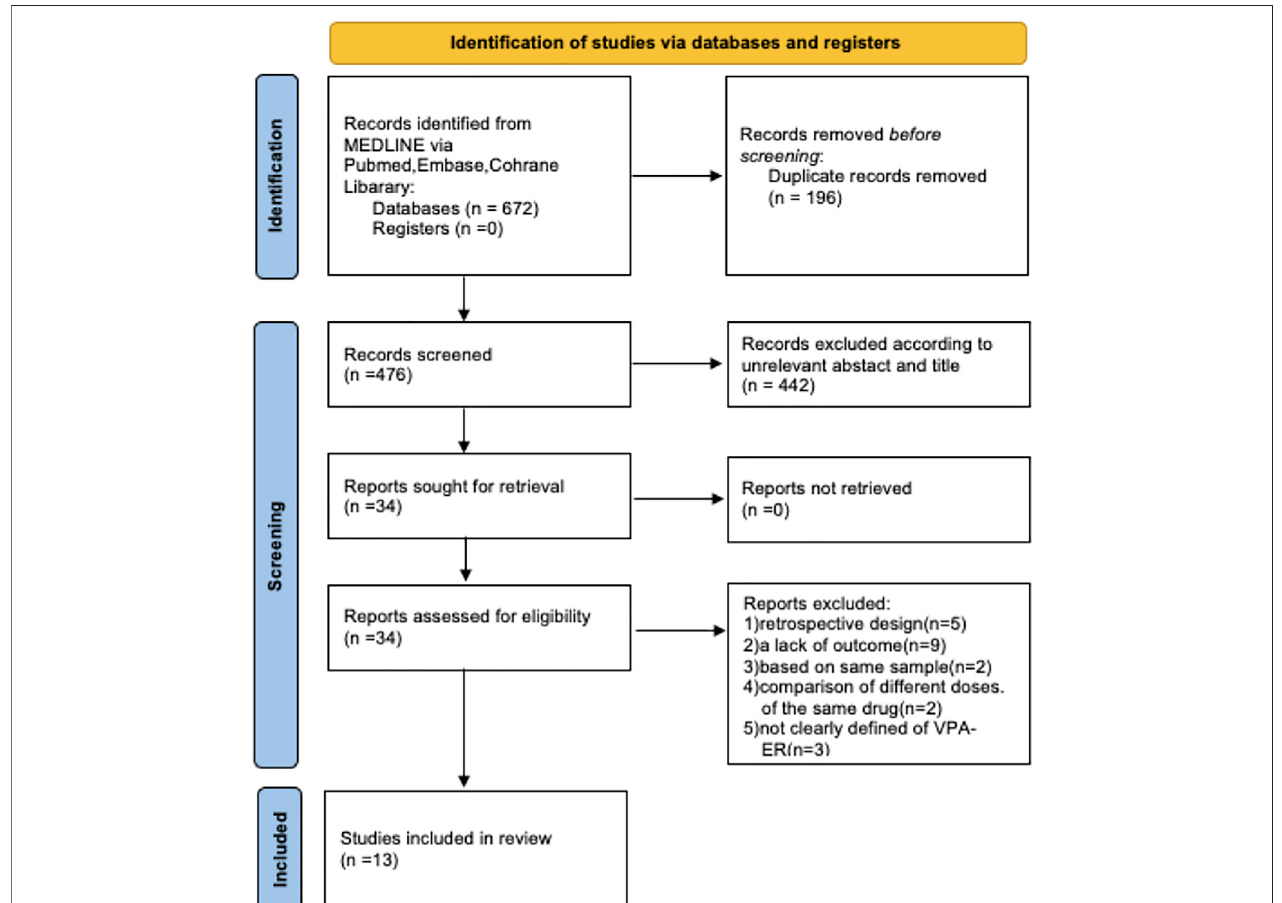
FIGURE 1 | Flowchart of selection studies for this